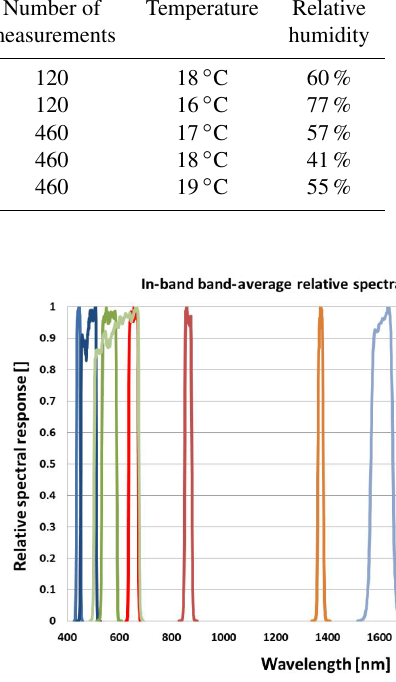
Figure 4. Band average relative spectral response filters for Land- sat 8 OLI sensor (USGS,